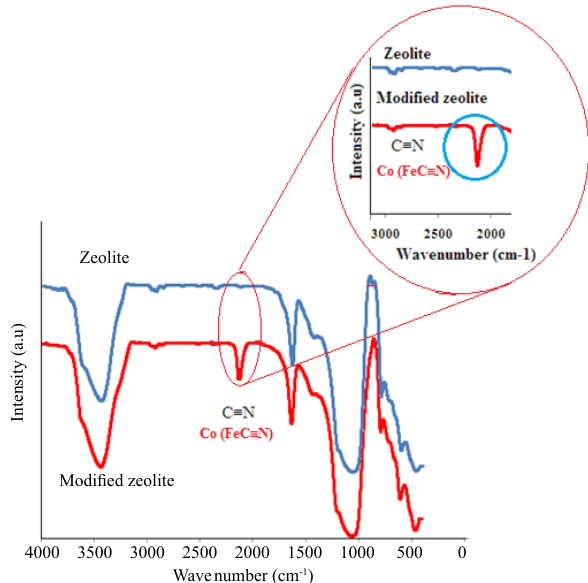
Wave number (cm -1 Fig. 1: FTIR spectra of bare and CoHCF loaded zeolites. Fig. 1 FTIR spectra of bare and CoHCF loaded zeolites.